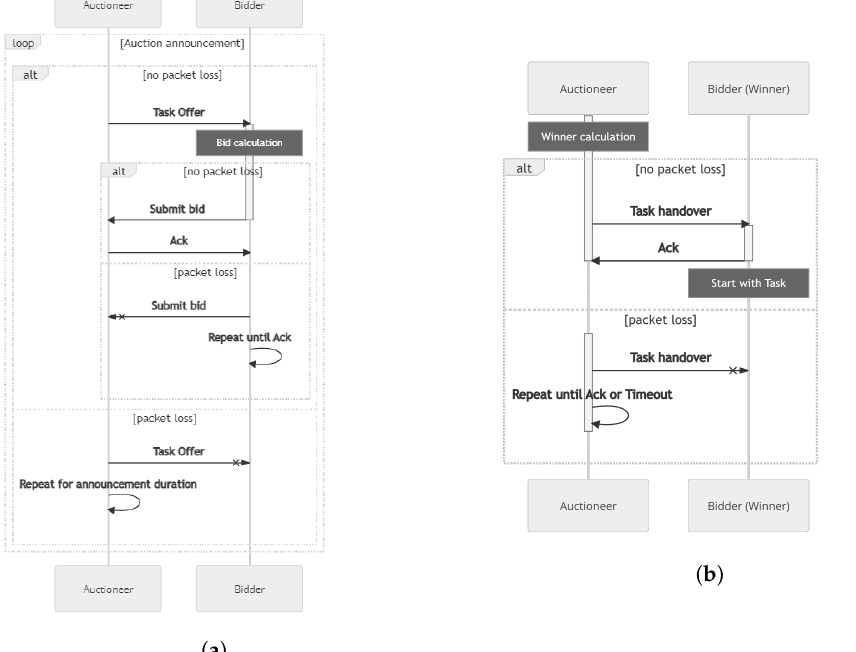
Figure 10. ( a ) The communication sequence between auctioneer and bidders for the auction an- nouncement and bid reception phase. ( b ) The communication sequence between auctioneer and bidders for the winner announcement and task handover